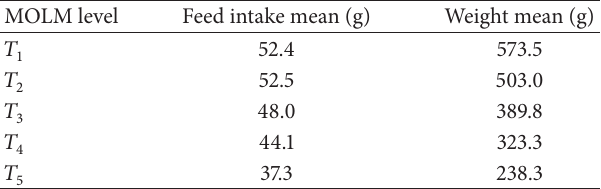
Table 5: Average feed intake and live weight (grams) for 6 weeks for the 5 MOLM inclusion